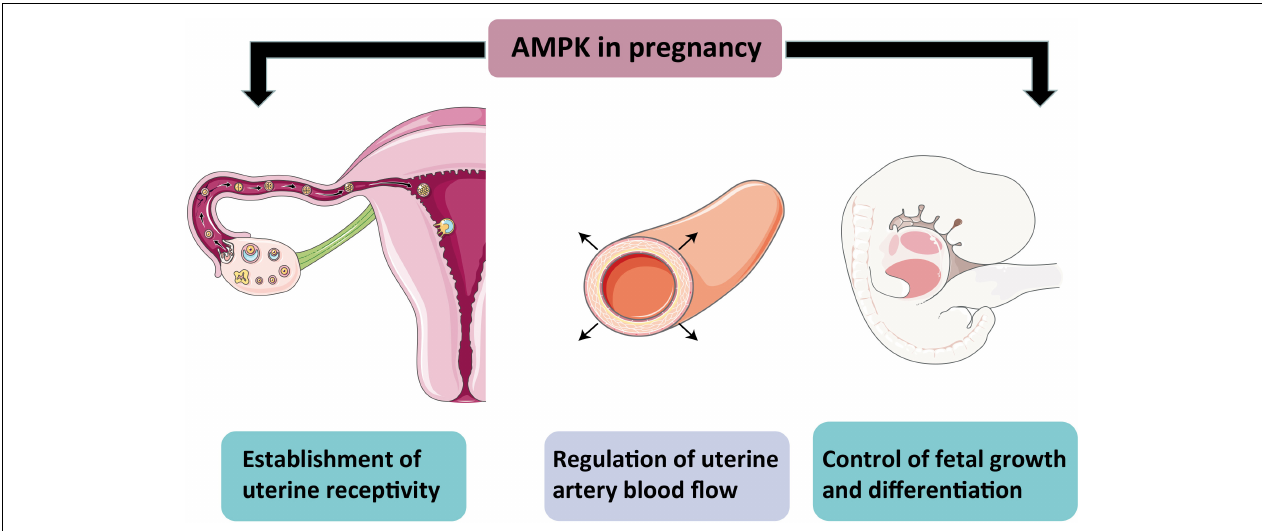
FIGURE 3 | Schematic representation of AMPK action in pregnancy. The diagram shows the importance of AMPK for a normal pregnancy. AMPK activity helps establish uterine receptivity and regulates arterial blood flow and controls normal fetal growth and development.